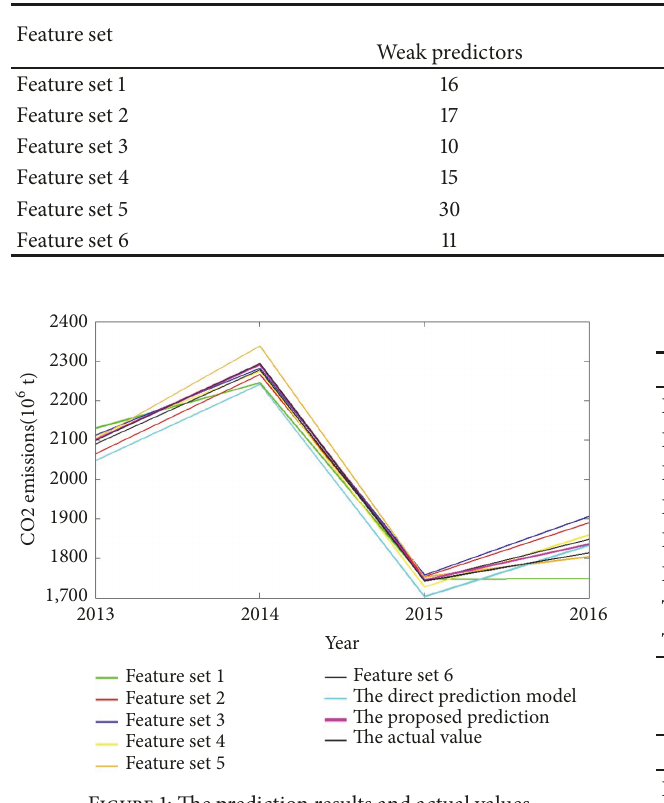
Figure 1: The prediction results and actual values.